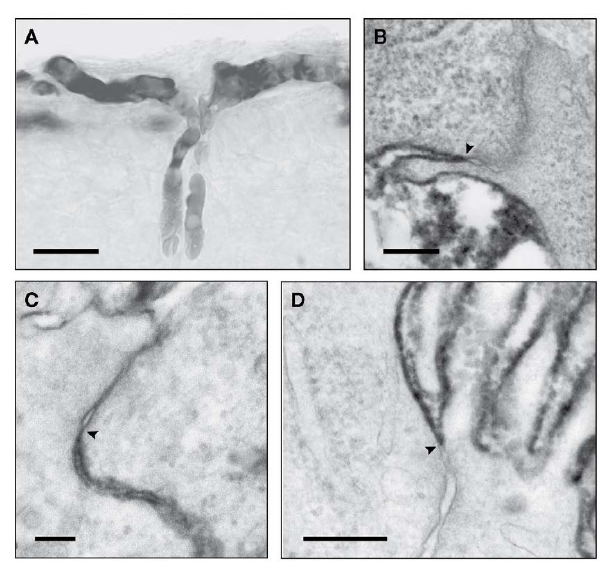
FIGURE 3 | Light (LM) and electronmicrographs (EM) of early developing brain blood vessels and choroid plexus, illustrating functional effectiveness of tight junctions. (A) (LM) and (B) (EM) of newborn opossum injected intraperitoneally (i.p.) with 3kDa biotin dextran. Reaction product confined to vessel lumen (A) not passing through tight junctions [ (B) , arrowhead]. (C) Newborn opossum choroid plexus injected i.p. with 3kDa biotin dextran which does not pass through tight junction (arrowhead). (D) E15 rat, tracer injected into lateral ventricle. Choroid plexus tight junctions (arrowhead): no passage of tracer between cells. Images: (A,B) from Ek et al. (2006); (C,D) from Ek et al. (2003). Scale bars: (A) , 25 μ m; (B) , 200nm; (C) , 100nm; (D) ,